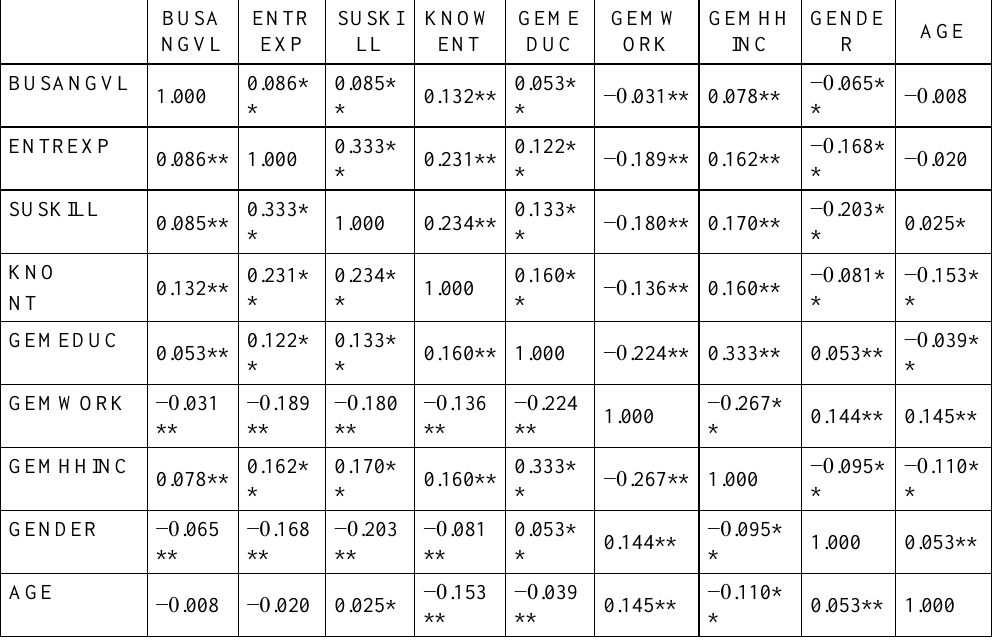
Table 4. The Spearman’s Rank Correlation of the Indicators Included in the Analysis of the Efficiency-Driven Economies of Central